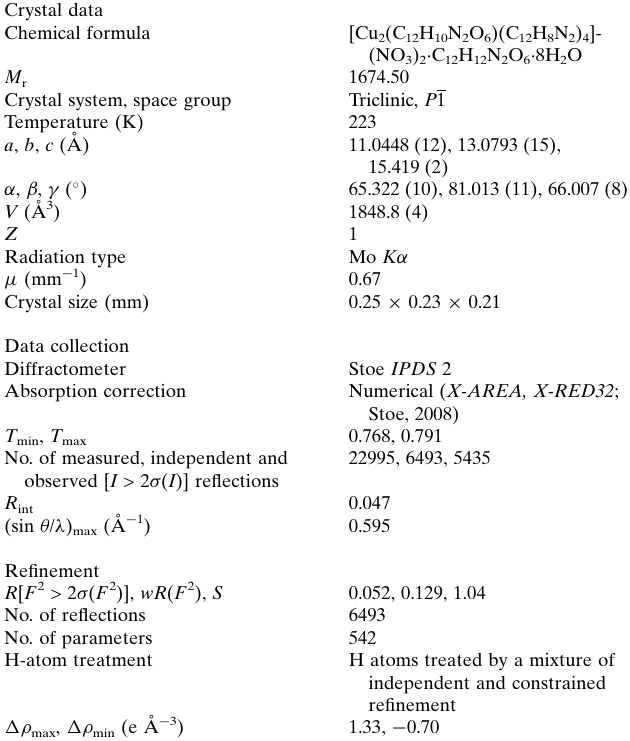
Table 2 Experimental details. Crystal data Chemical